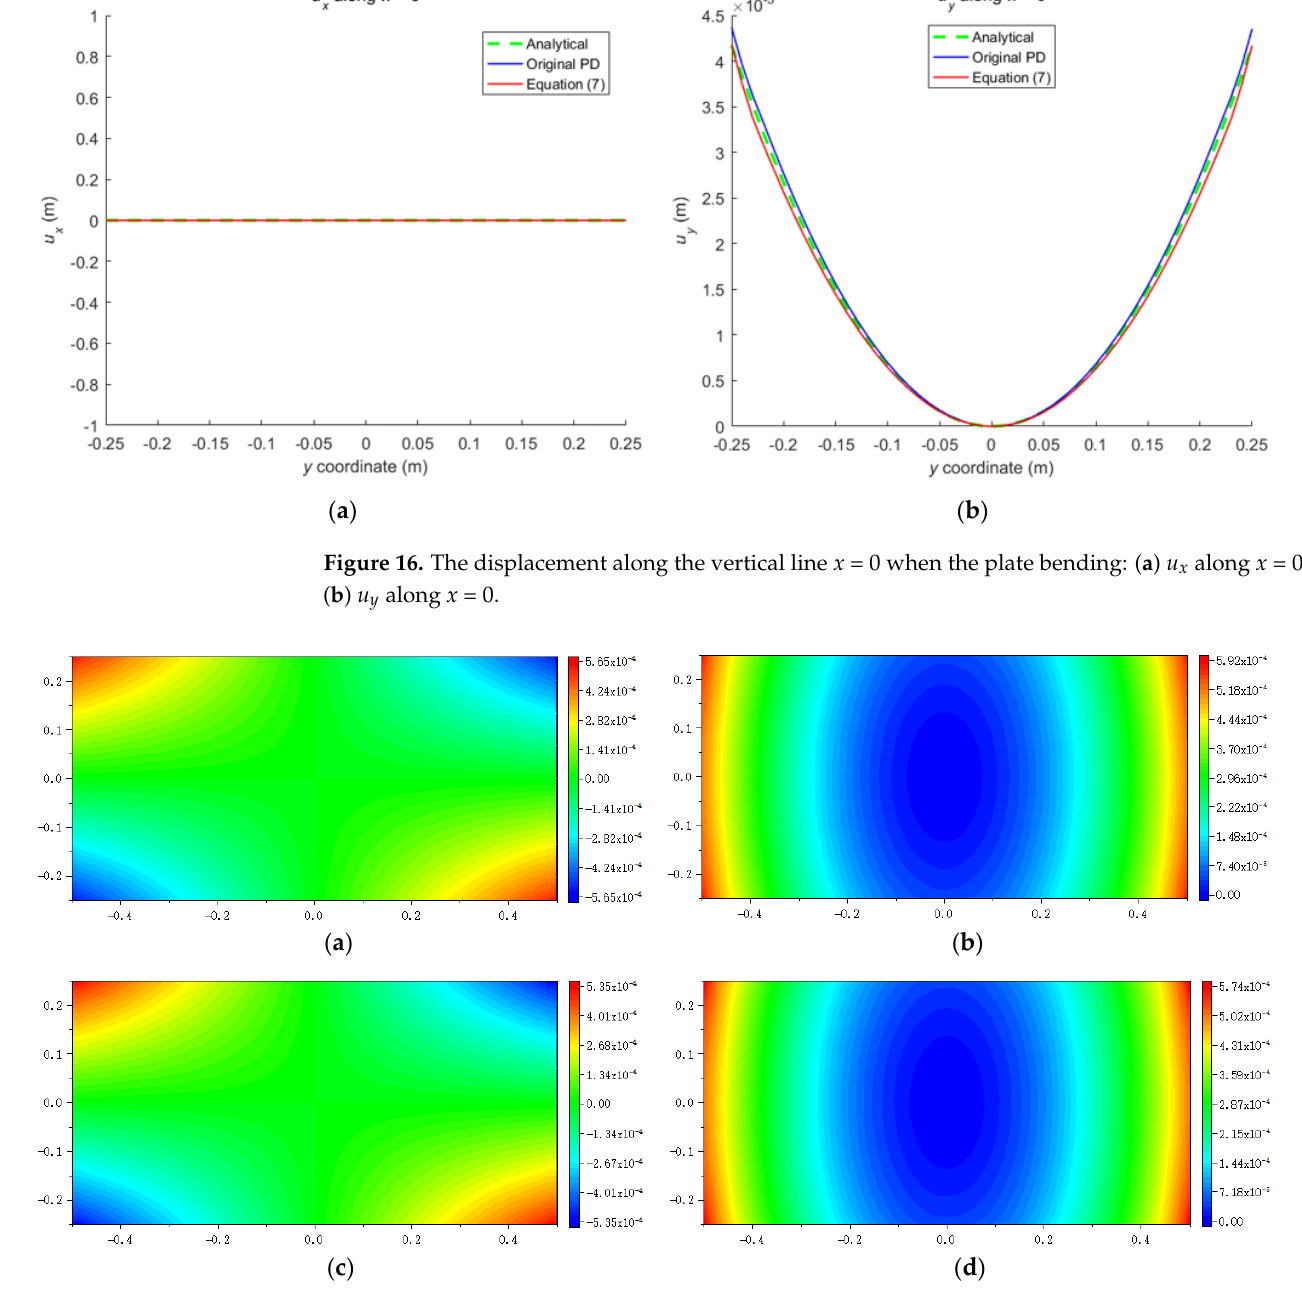
Figure 17. The distribution of displacement when the plate bending: ( a ) u x calculated by original PD; ( b ) u y calculated by original PD; ( c ) u x calculated by Equation (7); ( d ) u y calculated by Equation (7).